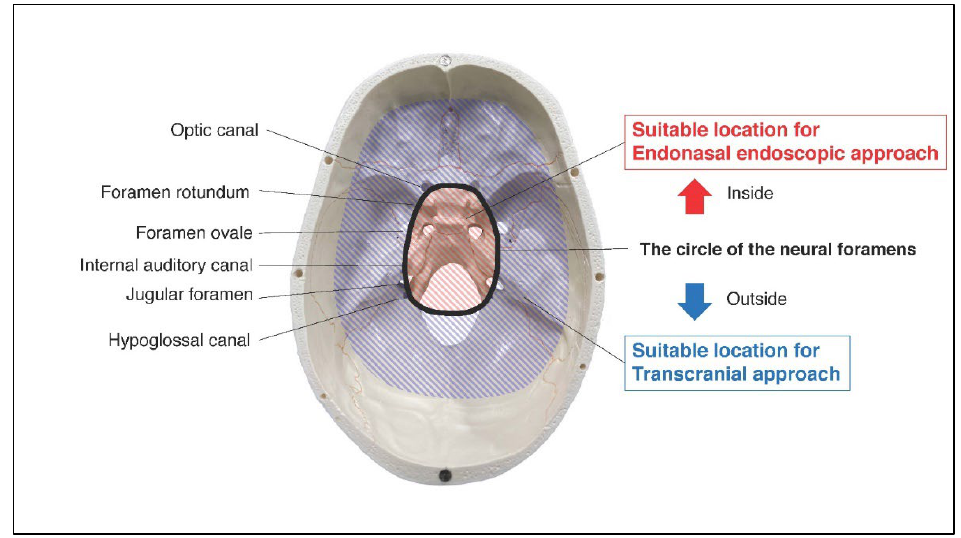
Figure 3. Red-striped region indicates the area with frequently resected by endonasal endoscopic approach. Blue-striped region indicates the area with frequently resected by transcranial approach. The border of them matched well the circle of the neural foramens (optic canal, foramen rotundum, foramen ovale, internal auditory canal, jugular foramen, and hypoglossal canal).